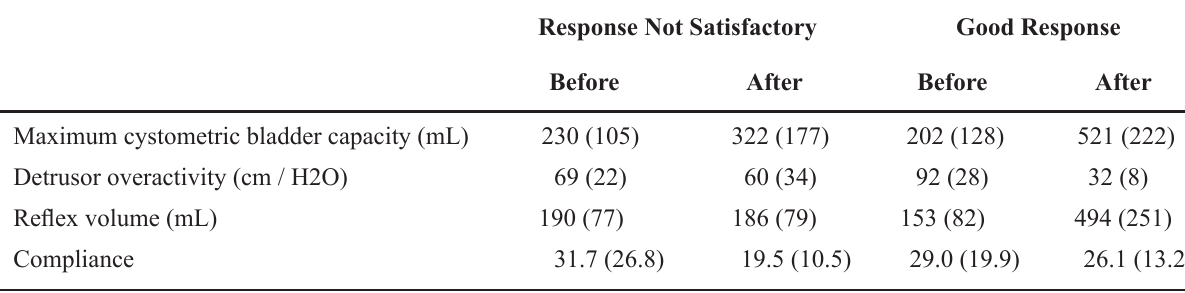
Table 2 – Urodynamic parameters (mean ± standard deviation) in patients with response not satisfactory and with good response before and after botulinum toxin A